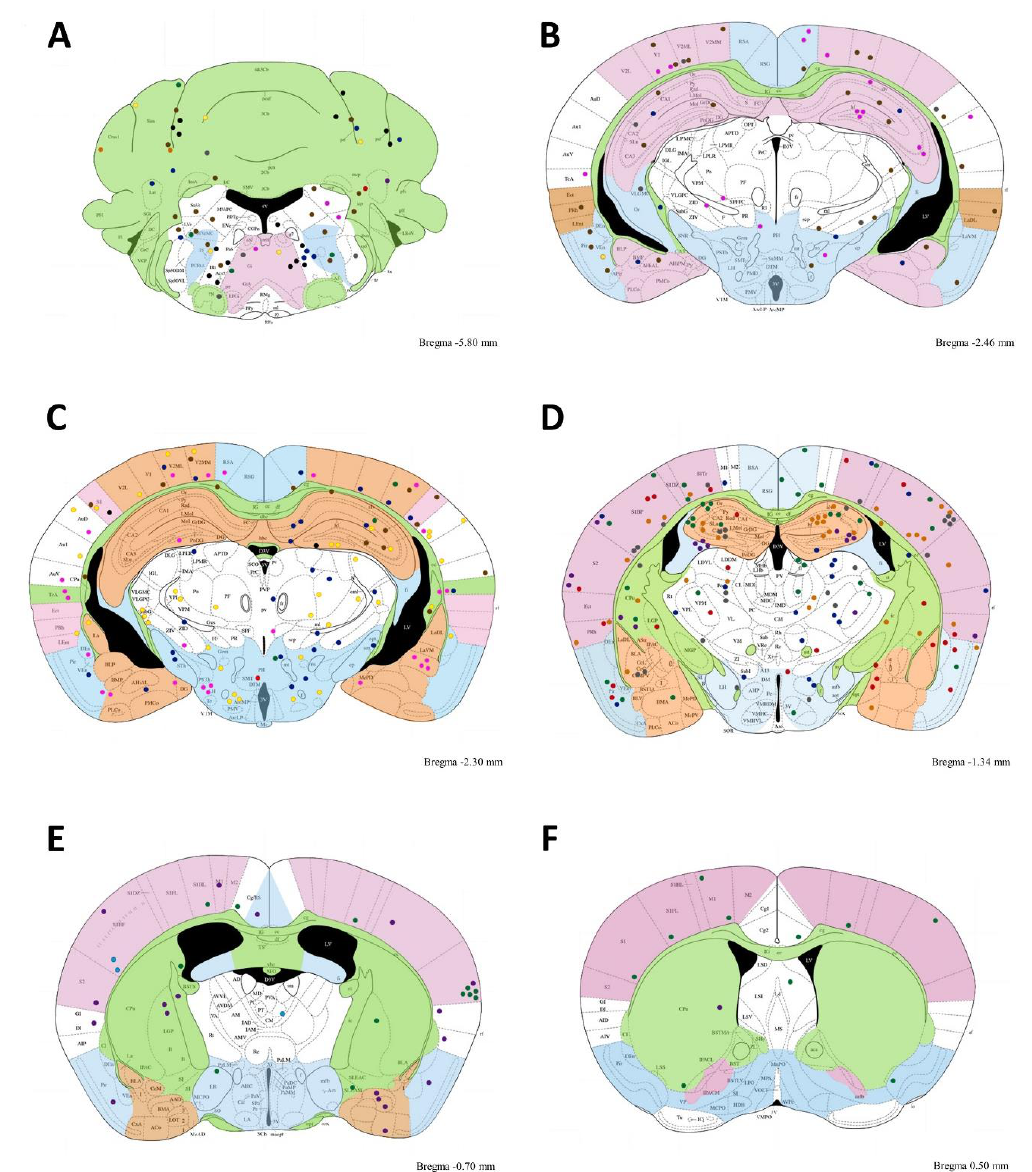
Figure 7. Brain schematic representing the cyst distribution accumulation. Grouping cysts between several rostral cuts in chronic infected mice. T. gondii cyst distribution. The figure illustrates several coronal histological cuts from bregma − 6.0 to bregma 0.38. Abbreviations indicate the brain zones (see abbreviation list). A – F A; B; C; D; E; F; ) Dots indicate brain cyst localization in twelve mice at a bregma distance indicated on the Figure for each cut. ( A ) Grouped cysts from bregma − 6.0 to − 5.8, ( B ) grouped cysts from − 2.54 to − 2.46, ( C ) grouped cysts from − 2.06 to − 2.30, ( D ) grouped cysts from − 1.94 to − 1.34, ( E ) grouped cysts from − 0.94 to − 0.70, and ( F ) grouped cysts from 0.38 to 0.50. Note in A there is cyst accumulation in Acs7, Irt, and Pa6. Additionally, in ( D ), there is cyst accumulation in the hippocampal zones and SIBF zone; ( E ) shows cyst accumulations in S2. All cysts pink color correspond to those illustrate in Figure 6.